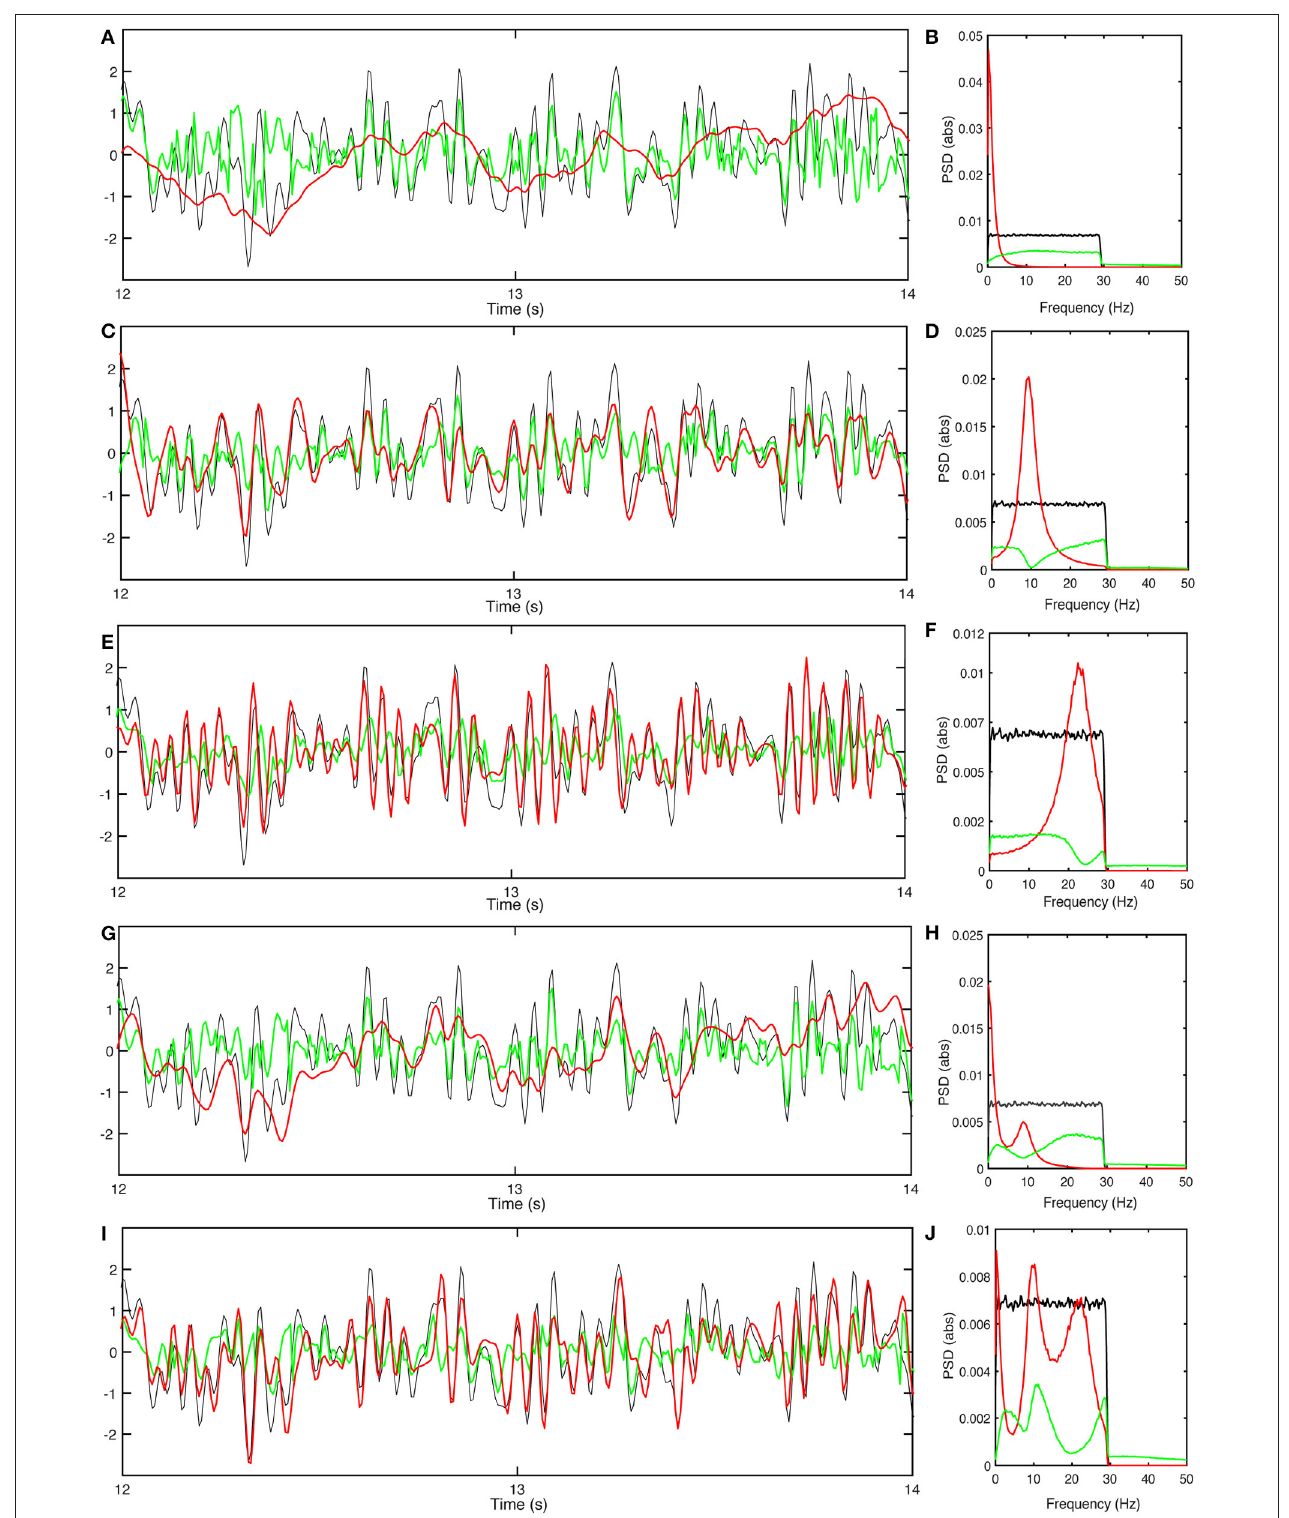
FIGURE 7 | Responses of the population e with gain adjustment, and corresponding power spectra. (A) Time series of stimulus (black), normalized-shifted filter t τ d output k φ en (red) and residual signal (green) for T low en . (B) Power spectra of response signals obtained for φ low en . (C) Same as (A) for φ alpha en . (D) Same as (B) for − (cid:0) (cid:1) φ alpha en . (E) Same as (A) for φ beta en . (F) Same as (B) for φ beta en . (G) Same as (A) for 8 (0) en . (H) Same as (B) for φ (0) en . (I) Same as (A) for φ (I) en . (J) Same as (B) for φ (II) en .